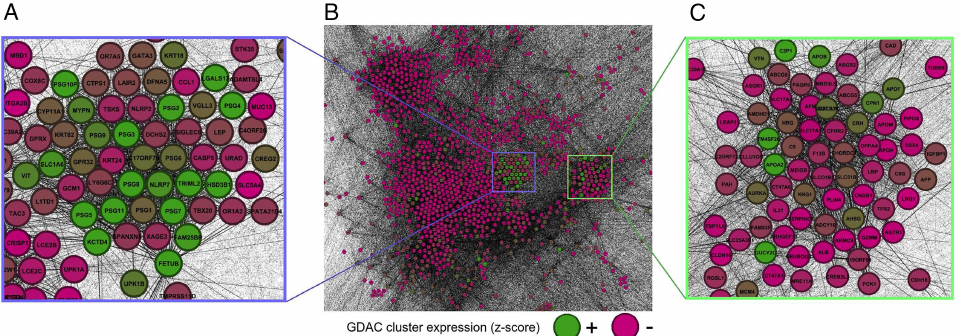
Figure 13. Force-directed layout [59]. ( B ) is the global picture. ( A , C ) are local enlargings. Green means high gene expression and red means low gene expression. Nodes with relationships are connected by wired segments, but nodes without relationships are not connected by wired segments.